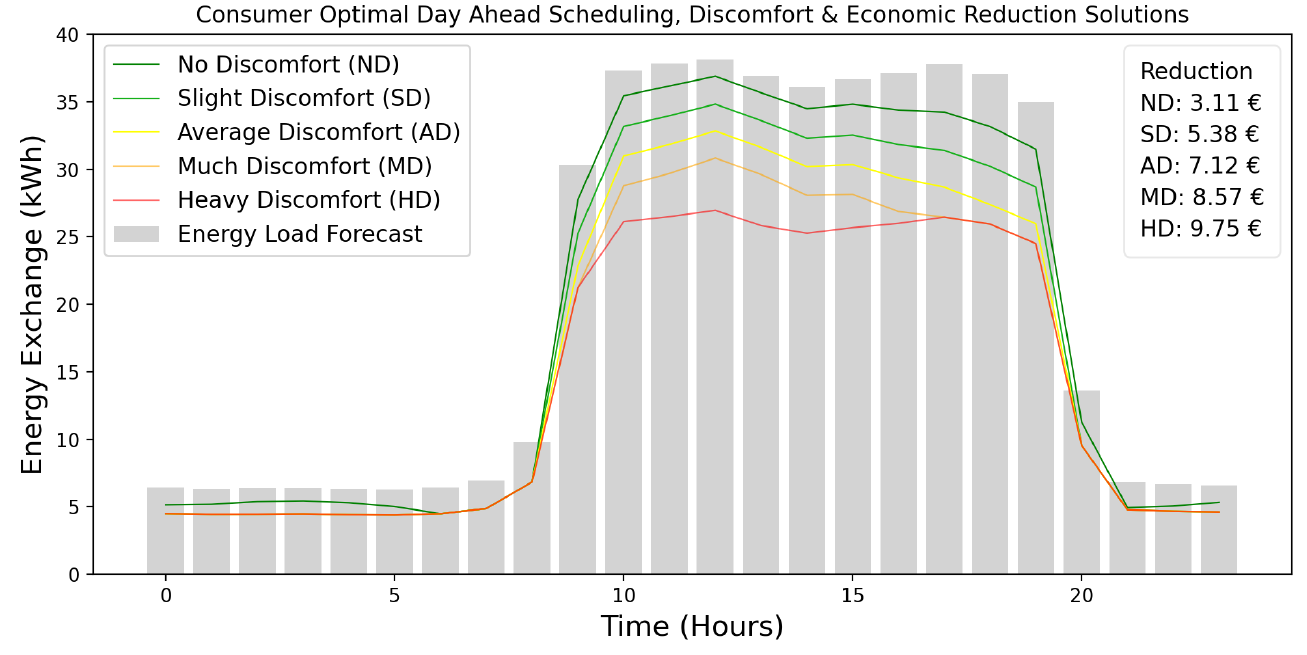
Figure 5. Optimization for a single